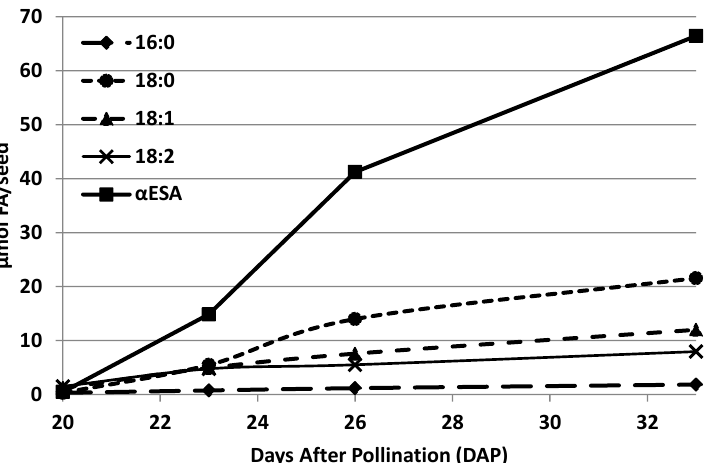
Except for 20 DAP, the relative amount of 18:2 in DAG remained relatively stable at 11–13% of all fatty acids. Its amount in TAG decreased from about 27% at 20 DAP to about 5.7% at 33 DAP. The differences in distribution of 16:0, 18:0 and 18:1 between different lipid classes were less pronounced compared to αESA and 18:2 (Figure 3).